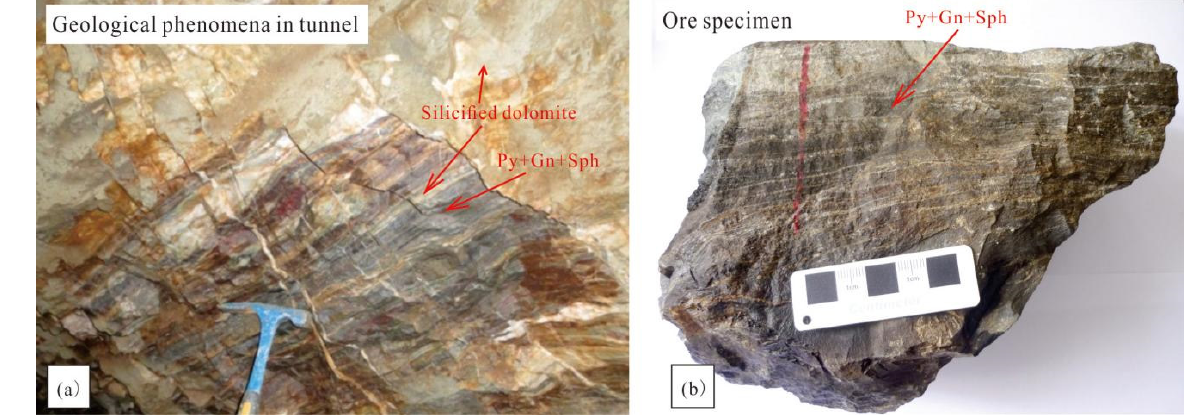
Figure 4. Strata-bound ore body ( a ) and ores with laminated structure ( b ). Abbreviations are as follows: Py, pyrite; Gn, galena; Sph, sphalerite.